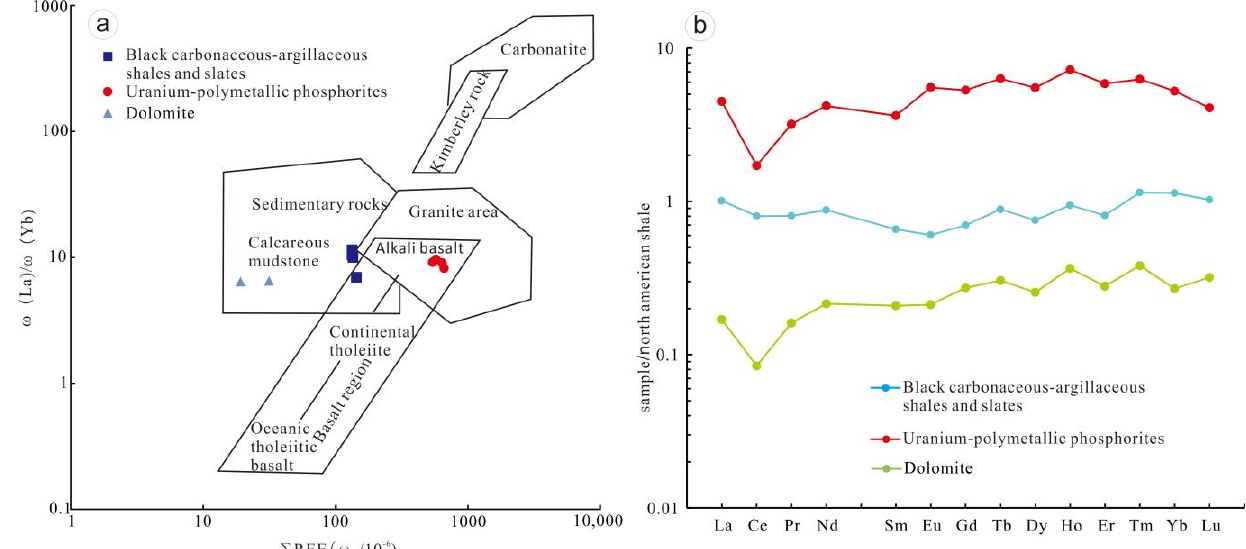
Figure 4. ( a ) A schematic of w (La)/w (Yb)-w ( ∑ REE) in the Baizhuyu deposit; ( b ) the average NASC—normalized distribution curves of REE in samples collected from the Baizhuyu deposit.